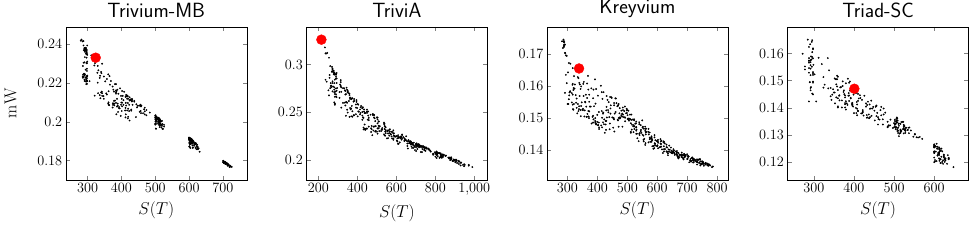
Figure 13: Power consumption figures as a function of the number of perfect trees for Trivium -like schemes. All data was obtained using the TSMC 90 nm process at a clock frequency of 10 MHz. Red data points mark the original